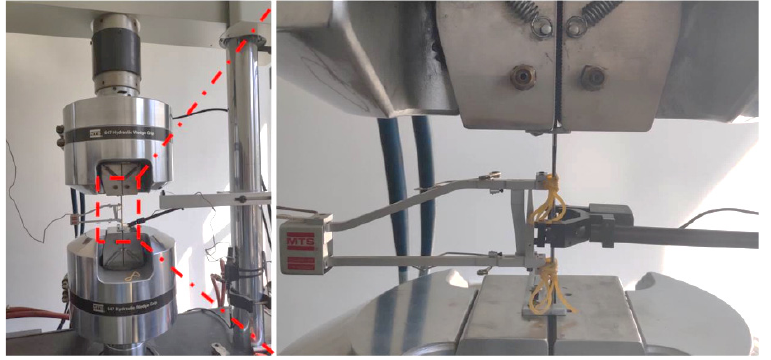
Figure 4. Experimental setup of the tensile test [35].